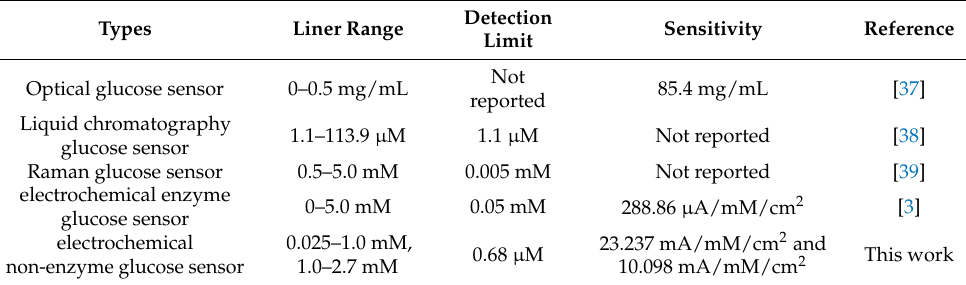
Table 2. Comparison of different types of glucose